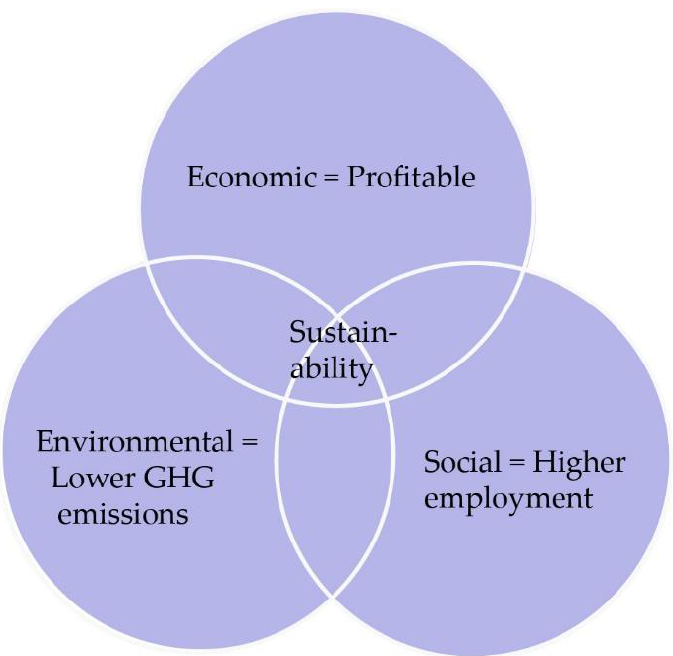
Figure 5. Simplified interpretation of the three pillars and sustainability. Figure 6. Simplified interpretation of the three pillars and